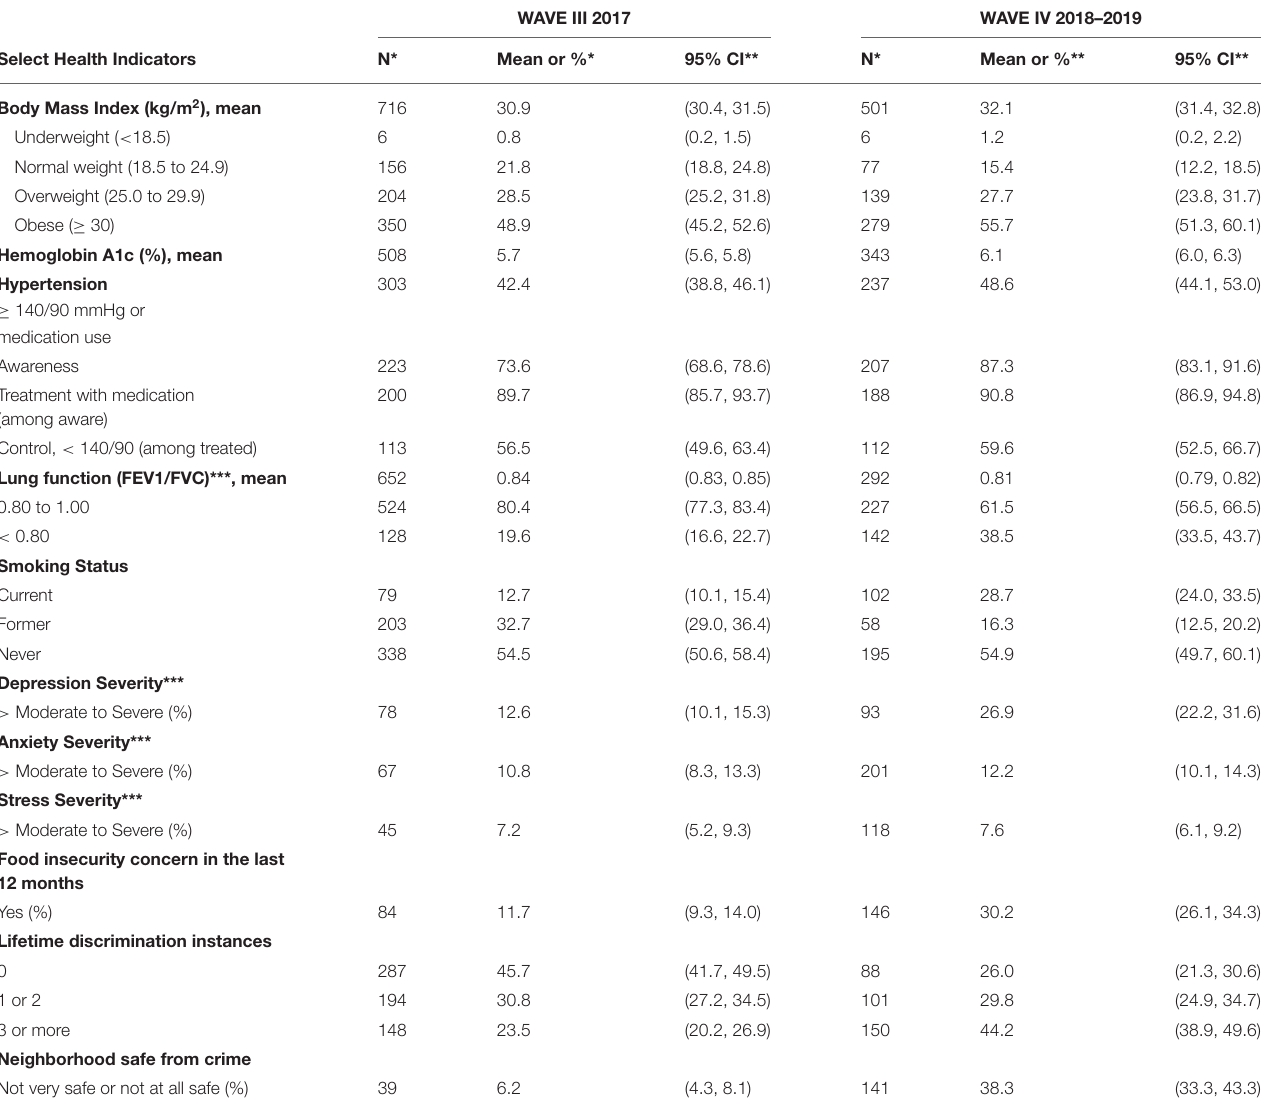
TABLE 4B | Select health indicators for SHOW adults WAVES III and IV,